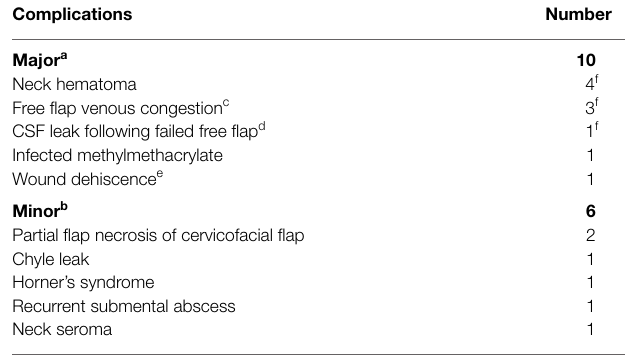
TABLE 2 | 23 Free Flaps and 8 Regional Flaps in 25 Patients a . Types of flaps